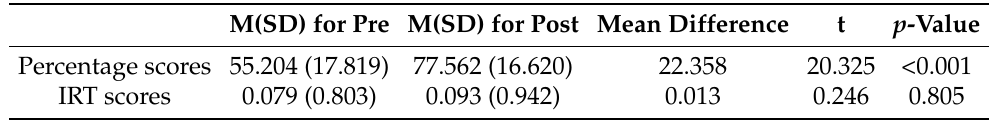
Table 2. Repeated-measures t -tests.